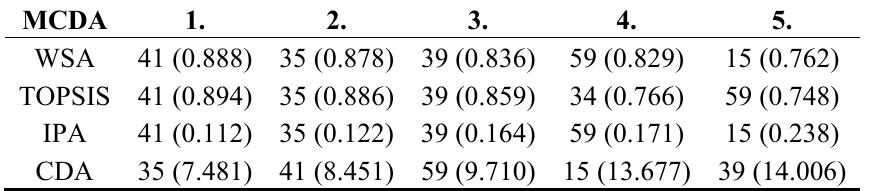
Figure 3. Environmental indicators of material compositions of external walls. Table 6. Final MCDA scores for environmental evaluation of external